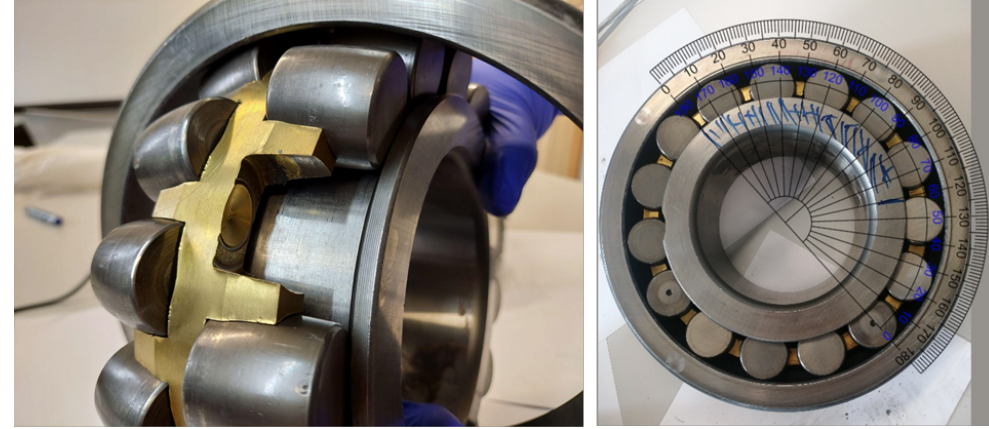
Figure 19. Picture of the not-damaged surface of the inner race and pitting angular size over the ring perimeter.